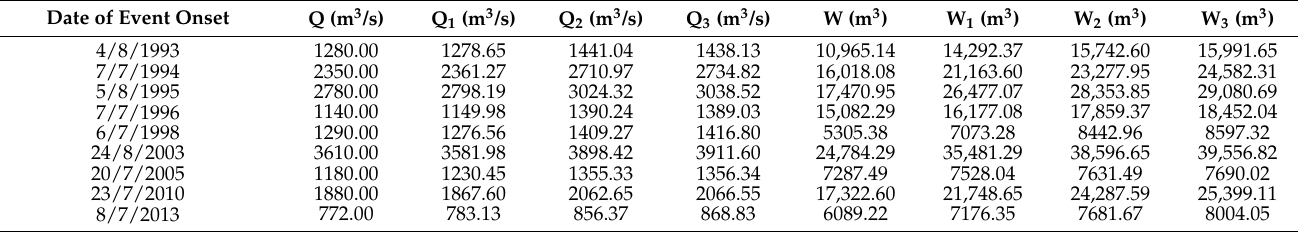
Table 7. Simulation of the JRB under the changing